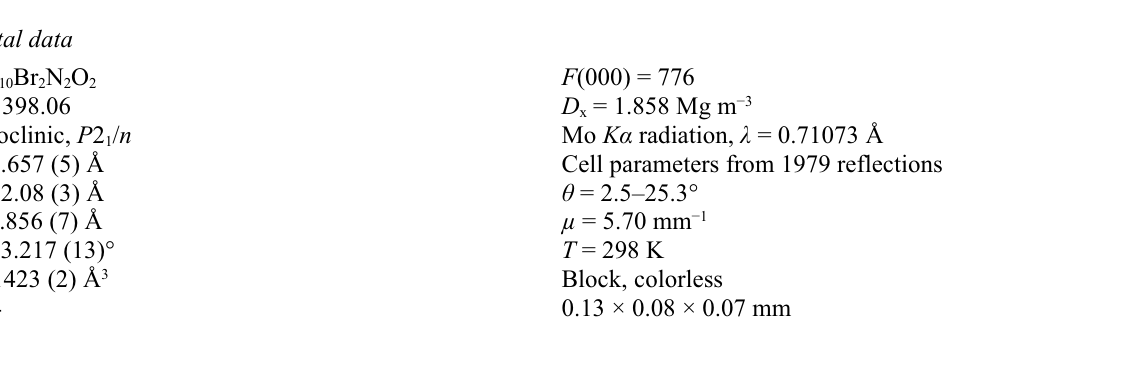
The molecular packing of (I), viewed along the a axis. Hydrogen bonds are drawn as dashed lines. ( E )-3-Bromo- N ′